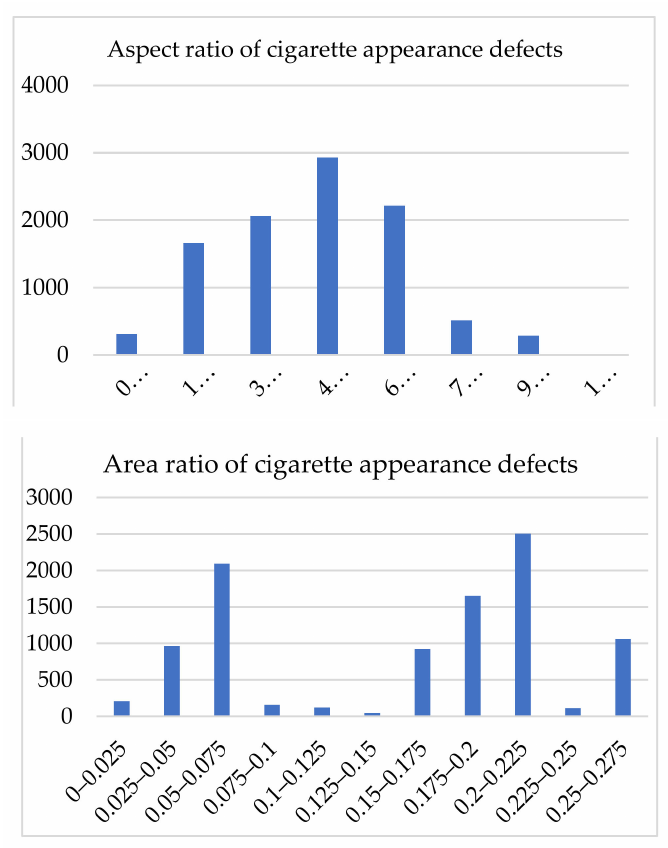
Figure 11. Details of cigarette appearance defect